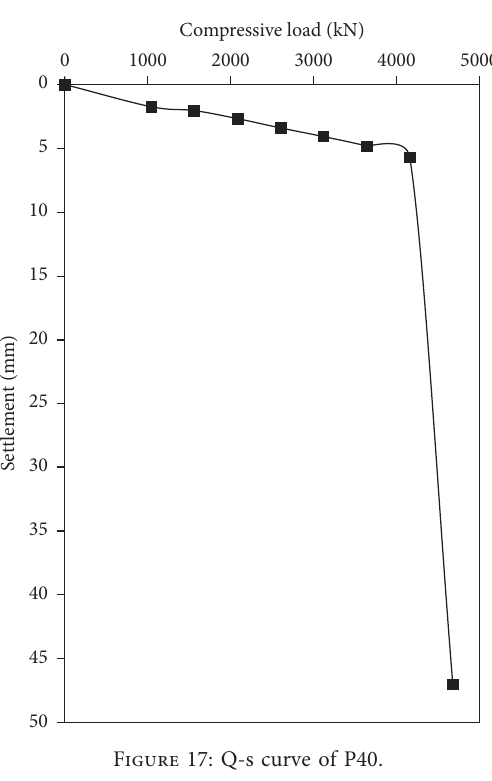
Figure 17: Q-s curve of P40.